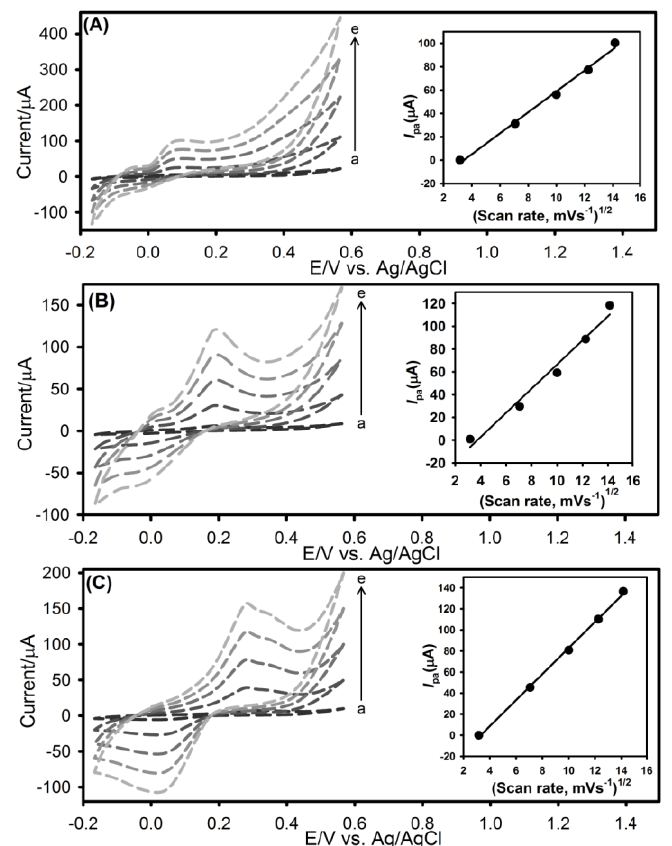
Figure 3. Cyclic voltammograms recorded at rGO-SPCE in BR buffer (pH 7.0) containing: ( A ) 0.5 mM UA; ( B ) 5.0 mM AA; and ( C ) 0.5 mM DA, at scan rates of: ( a ) 10; ( b ) 50; ( c ) 100; ( d ) 150; and ( e ) 200 mV·s −1 . Inserts: I pa vs. √ v .